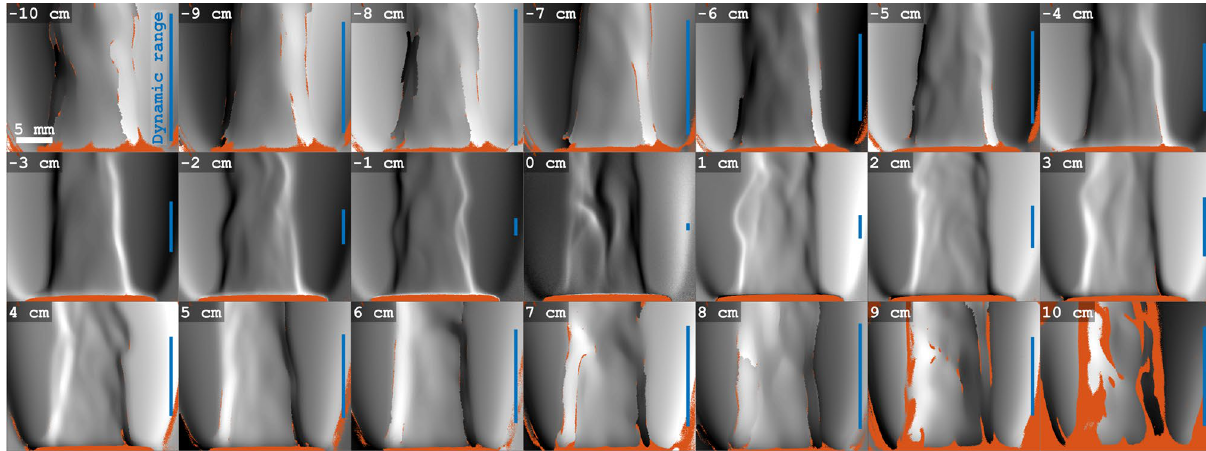
Figure 3. Phase shift images for varying target positions. The images have been acquired and reconstructed according to the FRAME method, followed by phase unwrapping. Negative distances correspond to positions closer to the illumination. Orange areas indicate where the amplitudes were too low for accurate phase determination. The blue lines show the relative dynamic range of respective image, i.e. the difference between the maximum and the minimum phase